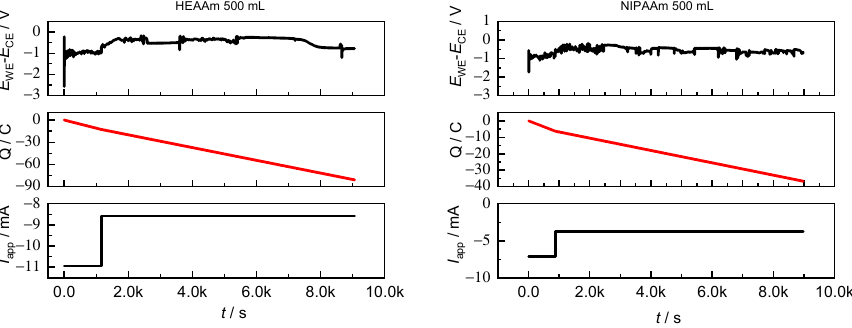
Figure 4. Profiles of E WE - E CE , Q, and I app vs. time recorded during the galvanostatic se ATRP of 10 wt% HEAAm and NIPAAm in H 2 O + 0.05 M NaBr + 0.05 M SP at T = 10 °C. V = 500 mL.